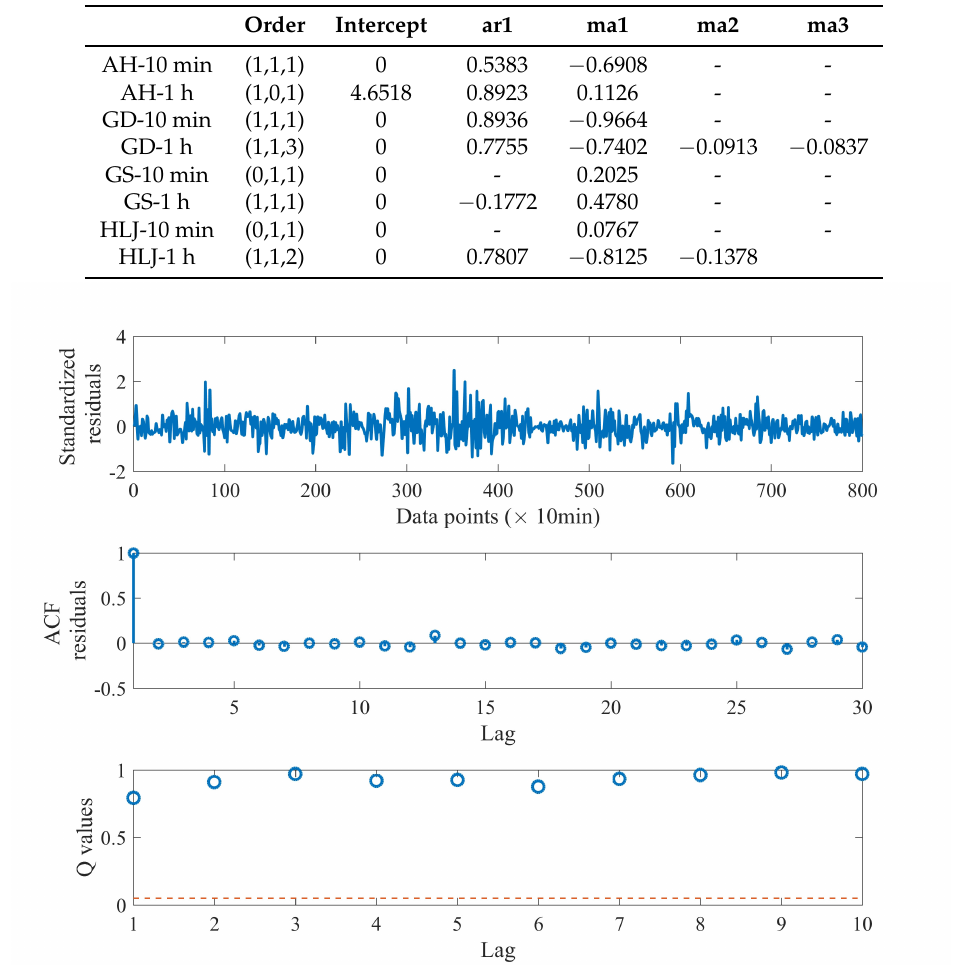
Figure 4. Parameter significance test results of single ARIMA(1,1,1) model for 10 min data from the AH site. ACF: Autocorrelation